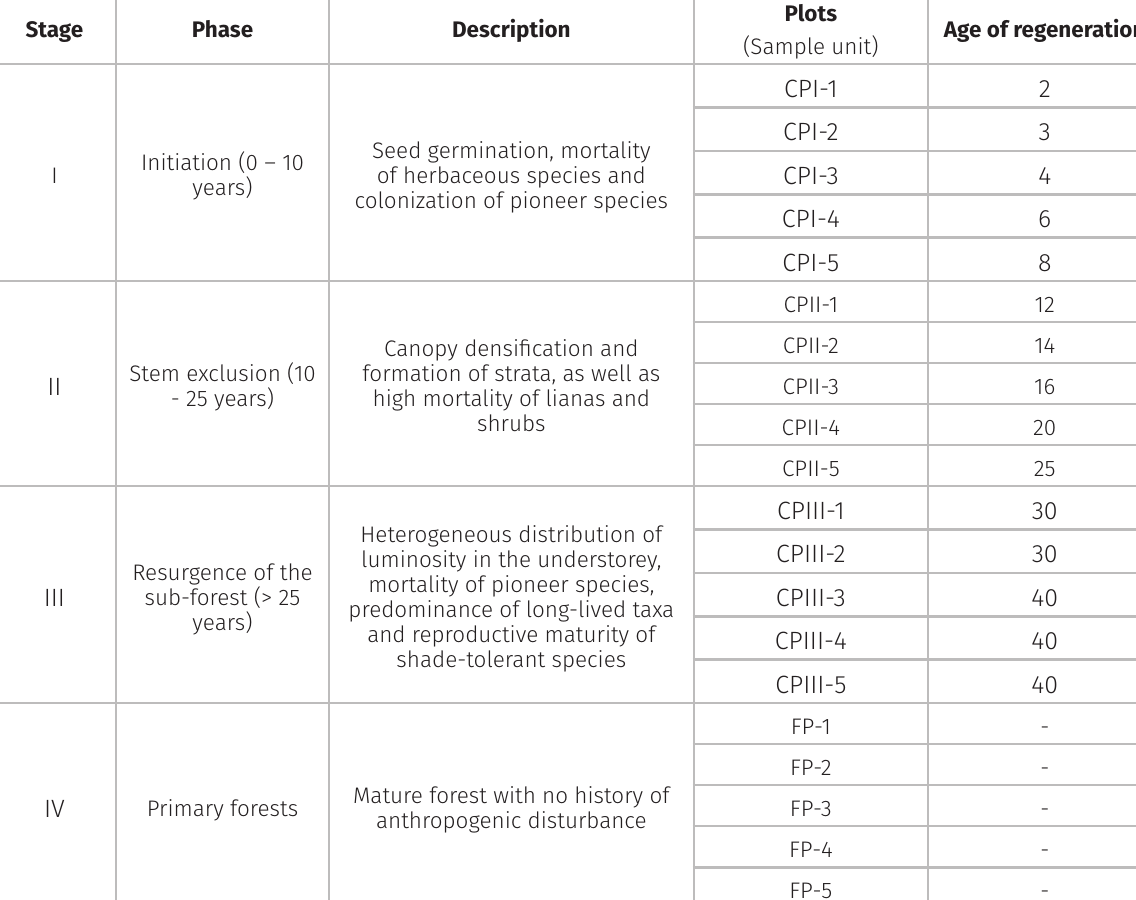
Table I. Characterization of collection plots and distribution of the number of samples per ecological successional stage according to the regeneration time in the Caxiuanã National Forest, Pará,